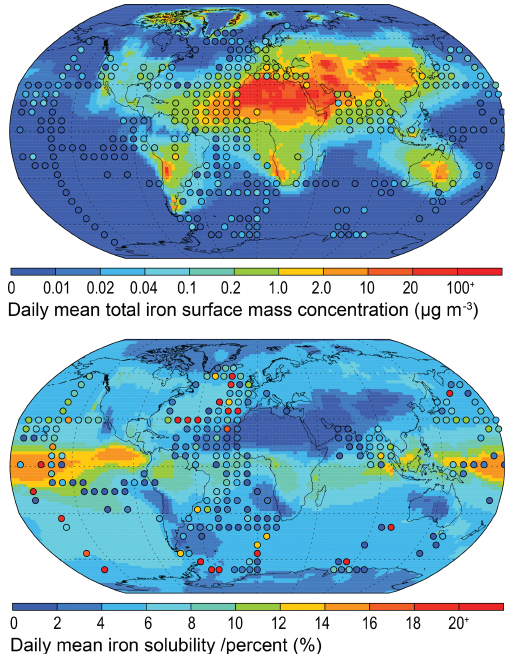
Figure 5. Daily mean model total iron concentration and solubility from 2007 to 2011. Observations (circles) overlaid (at a resolution one-third of the model grid) as a mean from 1524 individual records in Mahowald et al. (2009) and in Myriokefalitakis et al.